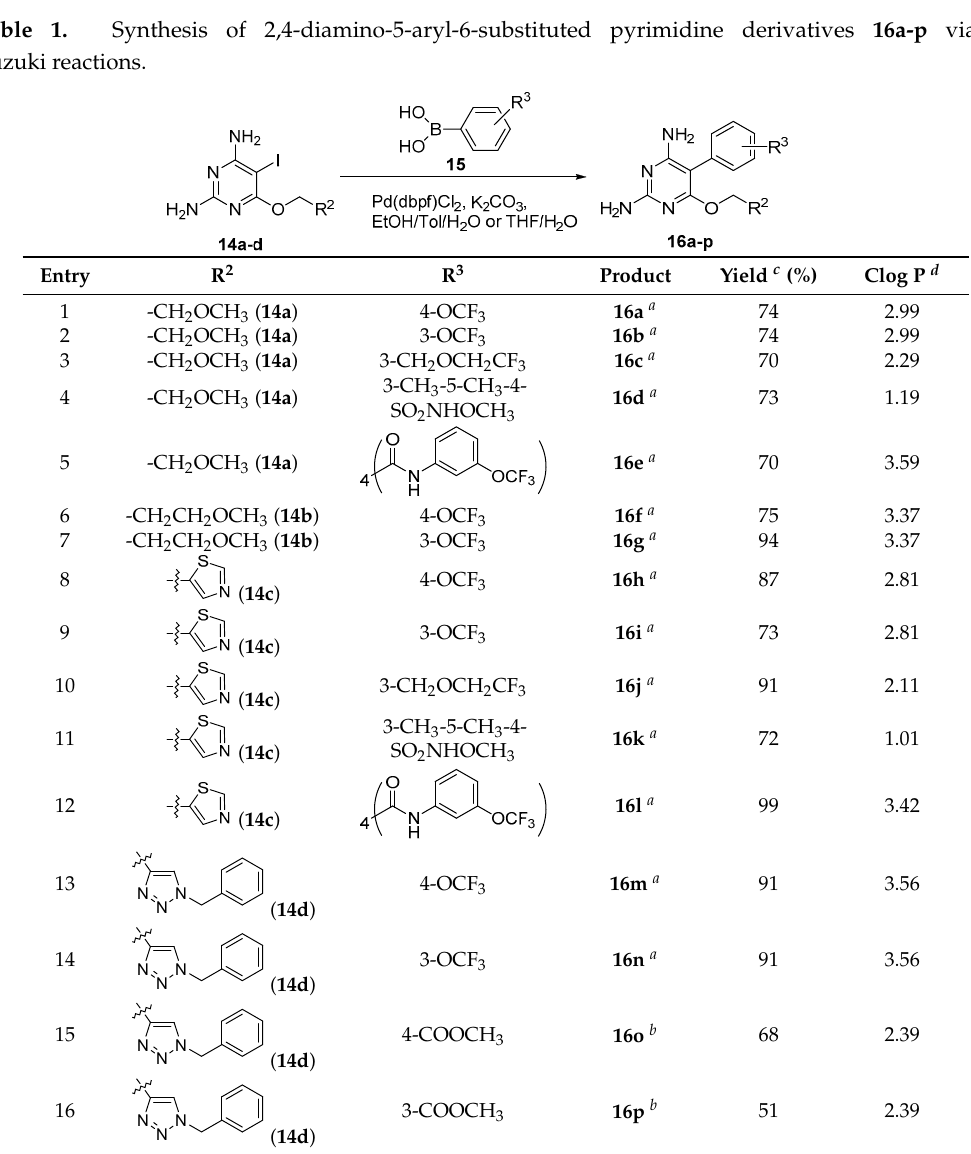
Synthesis of 2,4-diamino-5-aryl-6-substituted pyrimidine derivatives 16a-p via Suzuki reactions.